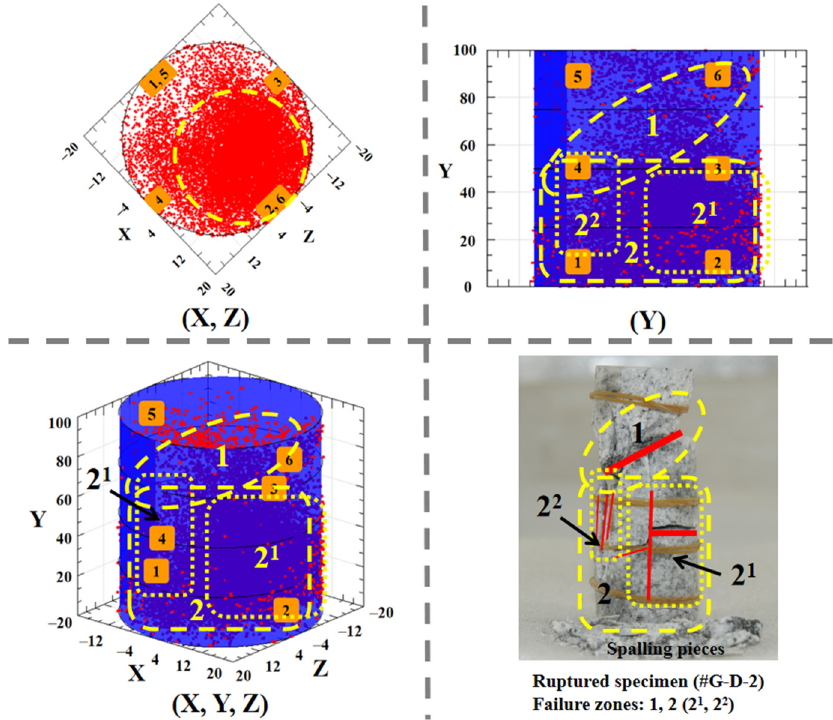
Figure 11. Failure areas and corresponding damage accumulation inside intact specimen of granite.